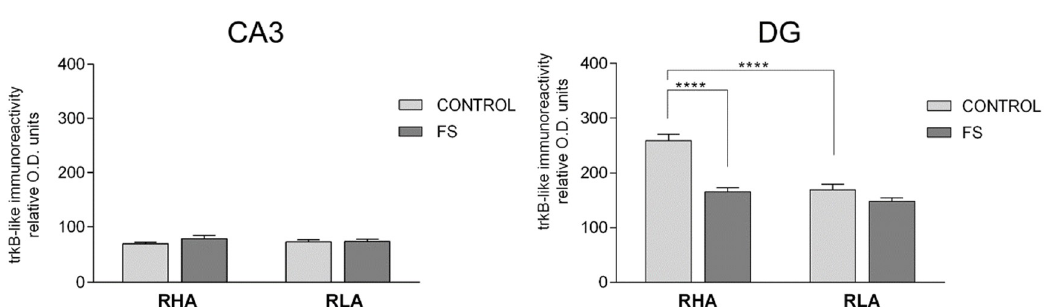
Figure 6. Densitometric analysis of the trkB-like immunoreactivity in the CA1–CA3 sectors of the Ammon’s horn and in the dentate gyrus (DG) of the dorsal hippocampus, in the baseline conditions (CONTROL) and after forced swimming (FS). Columns and bars denote the mean ± S.E.M. of six rats, in each experimental group. Two different sections were analyzed for each rat. ****: p < 0.0001 (Tukey’s post hoc test or Sidak’s correction for multiple comparisons).